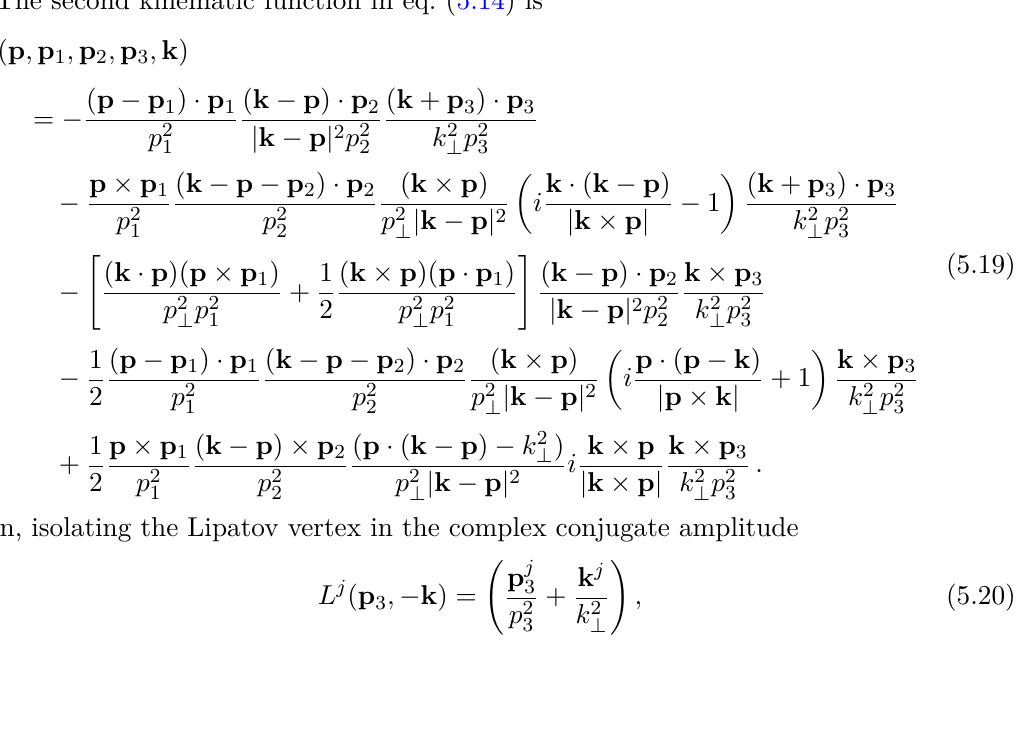
Figure 5 . Color structure for terms in the M ∗ two gluon lines cross the target nucleus and (b) three gluon lines cross the target nucleus. The dashed line separates the amplitude on the left and the complex conjugate amplitude on the